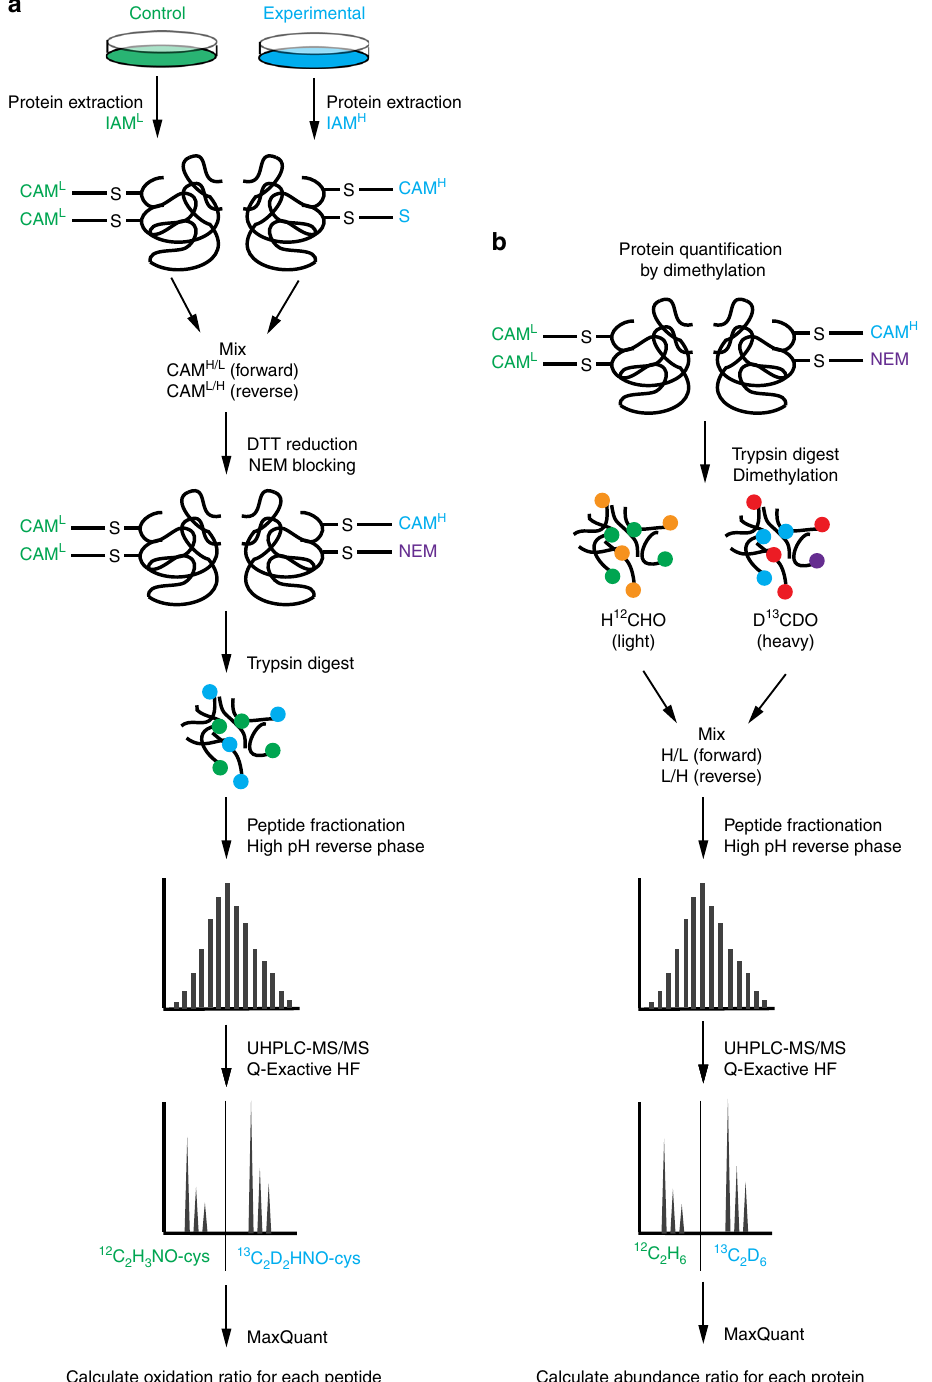
Fig. 1 Schematic overview of the Stable Isotope Cysteine Labelling with IodoAcetamide (SICyLIA) methodology. a Samples are extracted in presence of either light ( 12 C 2 H 4 INO) or heavy ( 13 C 2 D 2 H 2 INO) iodoacetamide (IAM) to alkylate free cysteine thiols, introducing a carbamidomethyl (CAM) group. Equal amounts of modi fi ed protein extracts are mixed, reversibly oxidised thiols are reduced with DTT and subsequently alkylated with NEM. Protein extracts are digested and peptides are fractionated prior to UHPLC-MS/MS analysis. b In parallel, labelled proteome extracts are trypsin digested and dimethylated using light (H 12 CHO/NaBH 3 CN) or heavy (D 13 CDO/NaBD 3 CN) formaldehyde/sodium cyanoborohydride, peptides are fractioned, and analysed using UHPLC-MS/MS similarly to IAM-modi fi ed peptides in mouse cells and 13,112 in kidney tissues (Fig. 2a). The SICyLIA work fl ow was applied to diverse biological To achieve accurate cysteine oxidation ratios, stringent quality models of acute (H 2 O 2 treatment) and chronic ( Fh1 de fi ciency) control (QC) criteria were applied. First, only peptide oxidation oxidative stress to assess its performance (Fig. 2). SICyLIA ratios quanti fi ed in at least three replicates were considered for enabled quanti fi cation of 18,022 unique cysteine-containing